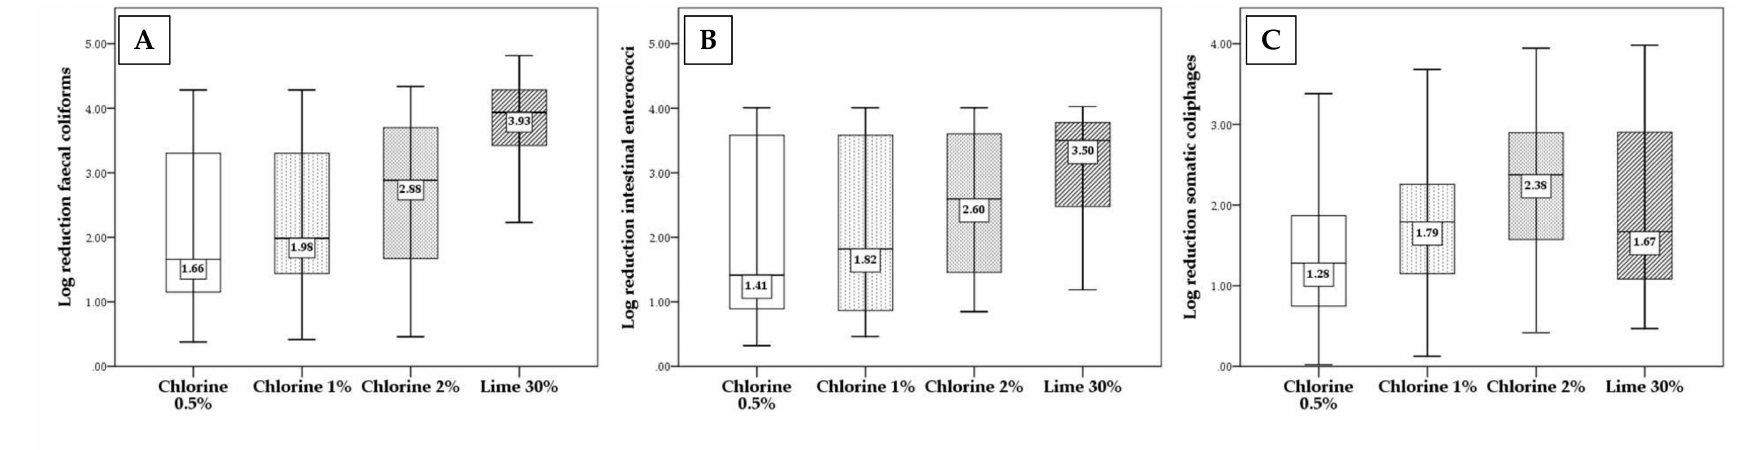
Figure 2. Box-plots displaying overall log reduction levels for faecal coliforms ( A ), intestinal enterococci ( B ), and somatic coliphages ( C ) following chlorine-based and hydrated lime-based approaches for the containment of human excreta